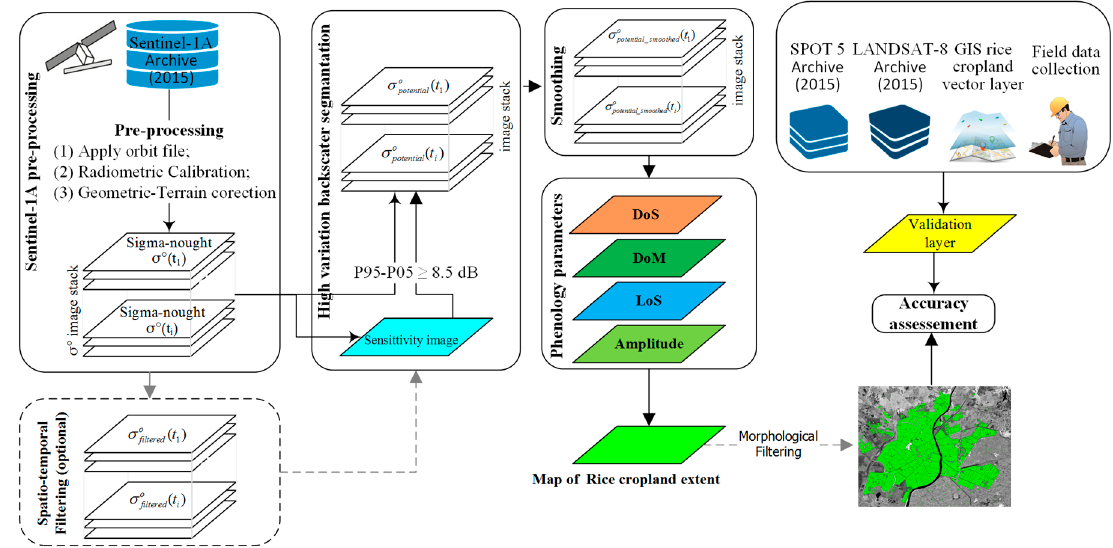
Figure 6. Systematic workflow of S-1 SAR (VH polarization) data processing, rice area classification and validation.